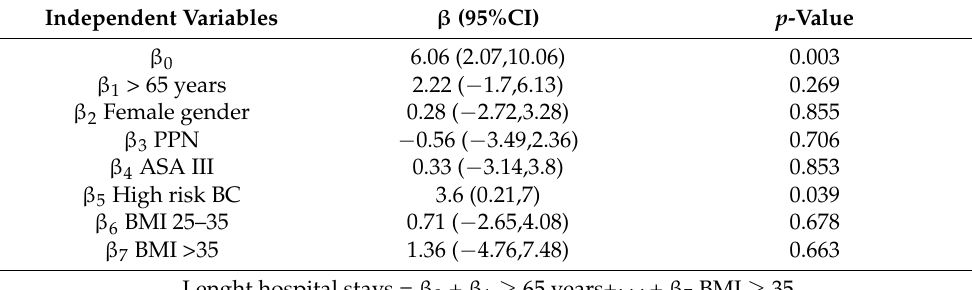
Table 4. Multiple linear regression with risk factors related to the